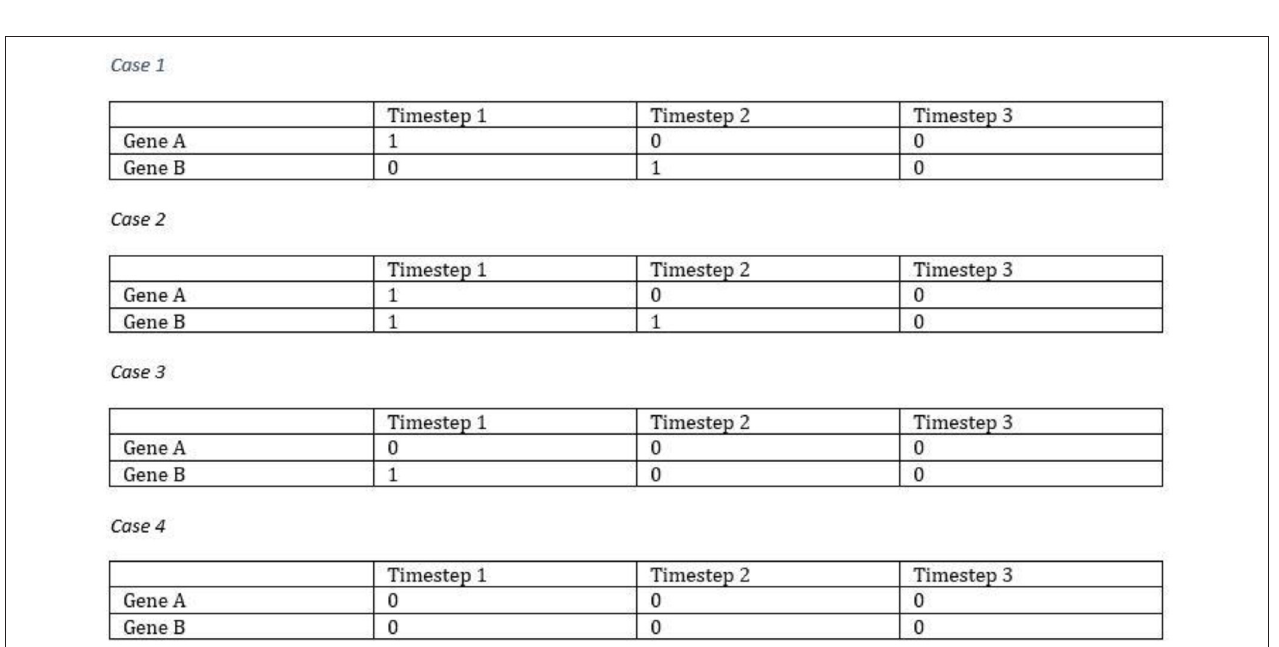
FIGURE 3 | Simulation of the dynamic equilibrium of gene